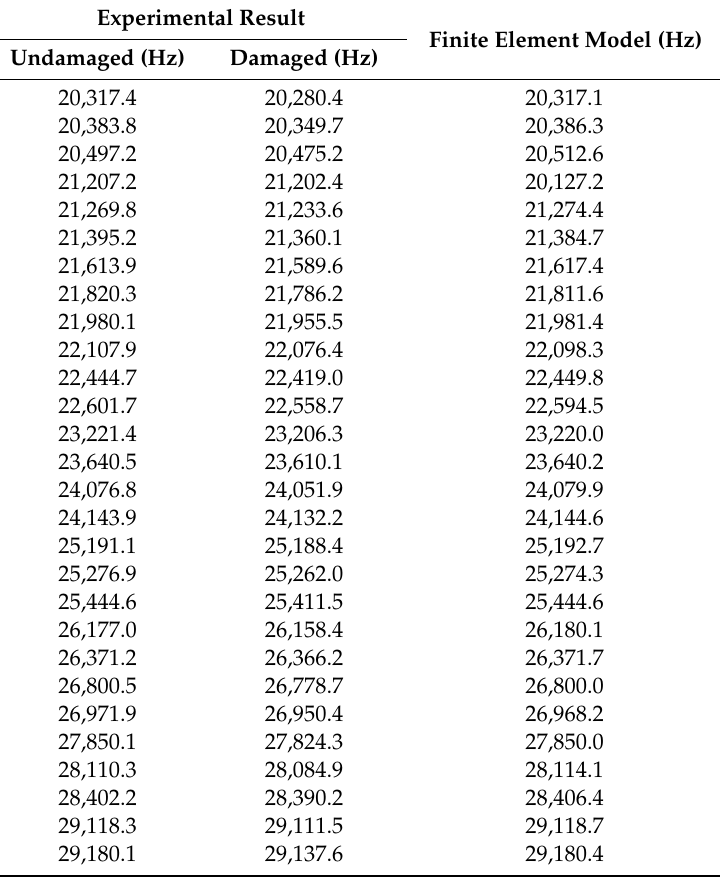
Table 4. Comparison of frequency shifts obtained from test results and